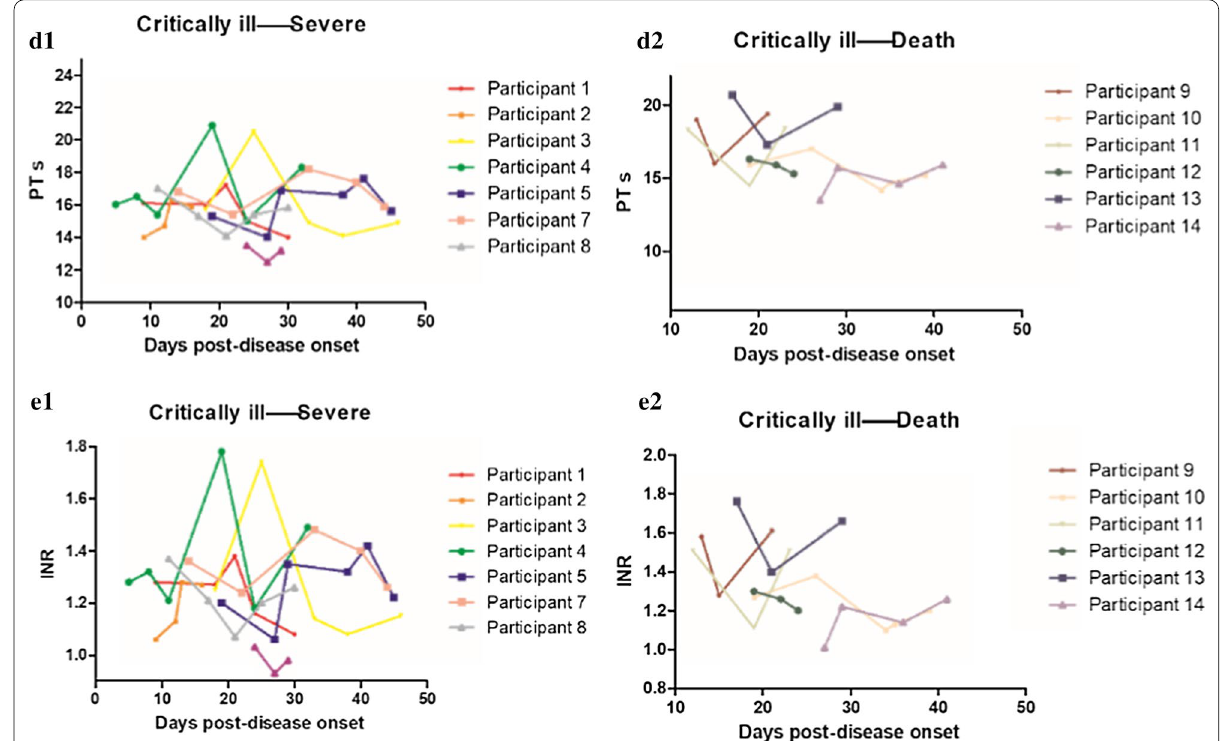
Fig. 4 Dynamic changes in blood coagulation indexes in the two outcomes when the critical illness turned into severe and the critical ill patients eventually died. D.1 , D.2 Dynamic changes of PT: when the critical illness turned into severe, the PT level increased at first and then decreased in most patients. When the critical illness turned into death, the PT level decreased at first and then increased in most patients. E.1 , E.2 Dynamic changes of INR: when the critical illness turned into severe, the INR level increased at first and then decreased in most patients. When the critical illness turned into death, the INR level decreased at first and then increased in most